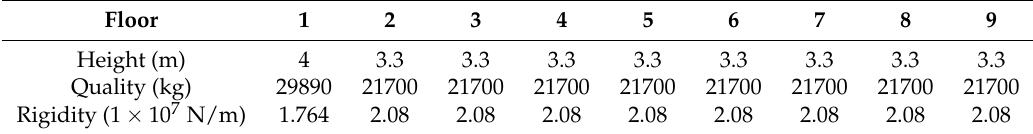
Table A1. Structural parameters of 9-floor